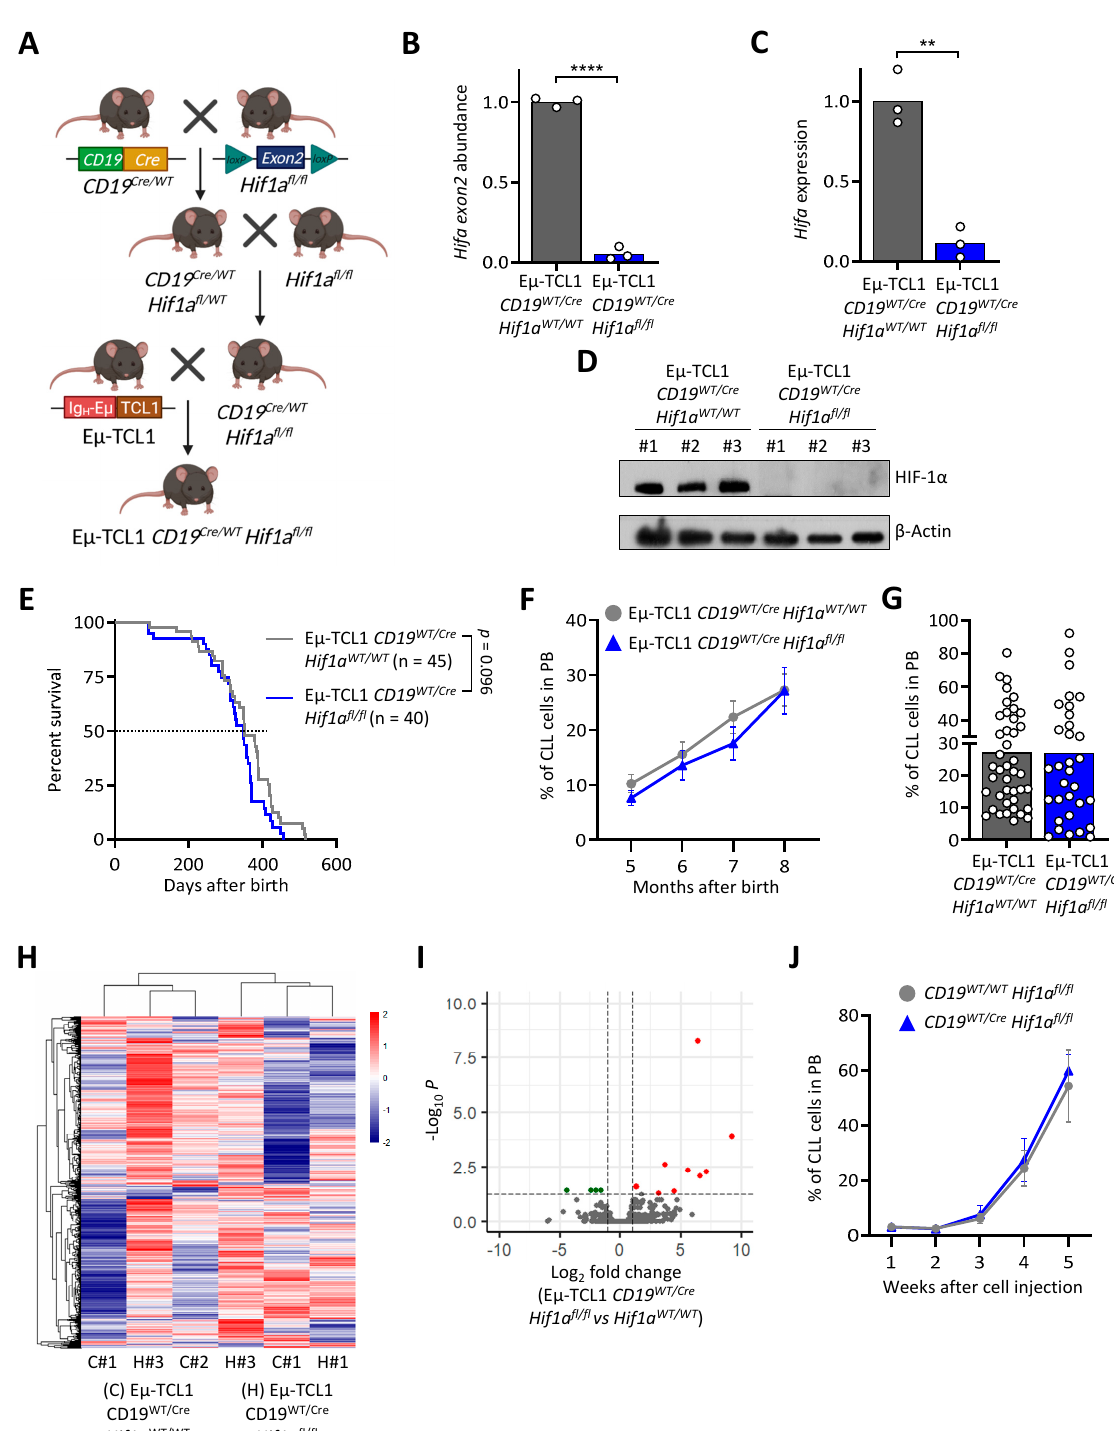
Figure 2. Knocking out HIF-1 α does not show an effect on the leukemogenesis of CLL cells in the murine E µ -TCL1 model. ( A ) Scheme of the breeding strategy to generate E µ -TCL1 CD19 Cre/WT Hif1a fl/fl (cKO). ( B – D ) Validation of the knock-out of exon 2 of Hif1a in isolated B cells from cKO mice incubated with CoCl 2 at the DNA ( B ), RNA ( C ), and protein ( D ) levels compared to control mice (n = 3). ** p < 0.01, **** p < 0.0001. ( E ) Survival curve of cKO compared to control mice shows no significant difference. ( F – G ) Flow cytometry analysis of CLL cells (CD19+ CD5+) in the peripheral blood (PB) of cKO and control mice over time (Ctrl: n = 45, cKO: n = 39) ( F ) and at month 8 (Ctrl: n = 42, cKO: n = 35) ( G ). ( H – I ) CLL cells from cKO and control mice (n = 3) were subjected to RNA sequencing. ( H ) Unsupervised hierarchical clustering showing the top 10,000 most expressed genes. ( I ) Volcano plot showing DEG between cKO and control mice. ( J ) CLL development of the adoptive transfer of E µ -TCL1 CLL cells in CD19 Cre/WT Hif1a fl/fl mice (Ctrl: n = 5, cKO: n = 6).